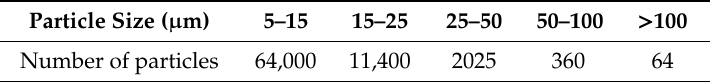
Figure A1. Schematic diagram of abrasive wear under lubrication condition. Table A1. Particle concentration of Grade 8 (number of particles in 100 mL).